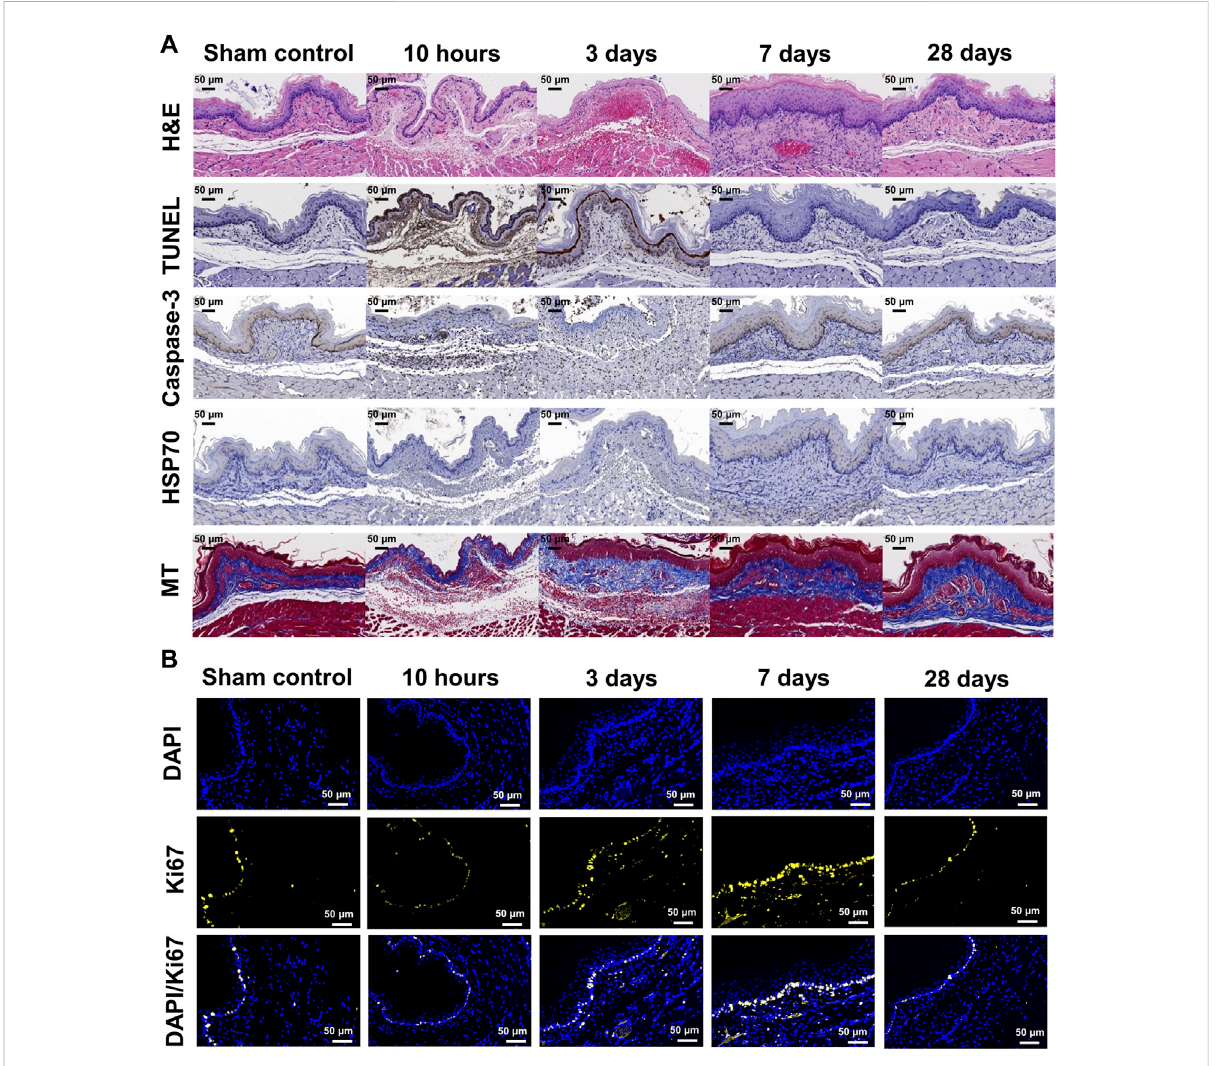
FIGURE 5 Representative microscopicimagesofhistopathological sections. (A) Hematoxylinandeosin-stained,TUNEL, caspase-3, HSP70,andMasson ’ s trichrome-stained sections are shown (×20 magni fi cation). Relative TUNEL and caspase-3 expression after stent-directed IRE increased at 10 h and 3 days after IRE treatment. Collagen deposition increased at days 7 and 28 . (B) Representative Ki67 immuno fl uorescence (DAPI, blue and Ki67, yellow) images showing active cellular regeneration at 7 days after IRE treatment (×40 magni fi cation). Representative microscopic images of the histopathological sections of the adjacent organs of the IRE-treated